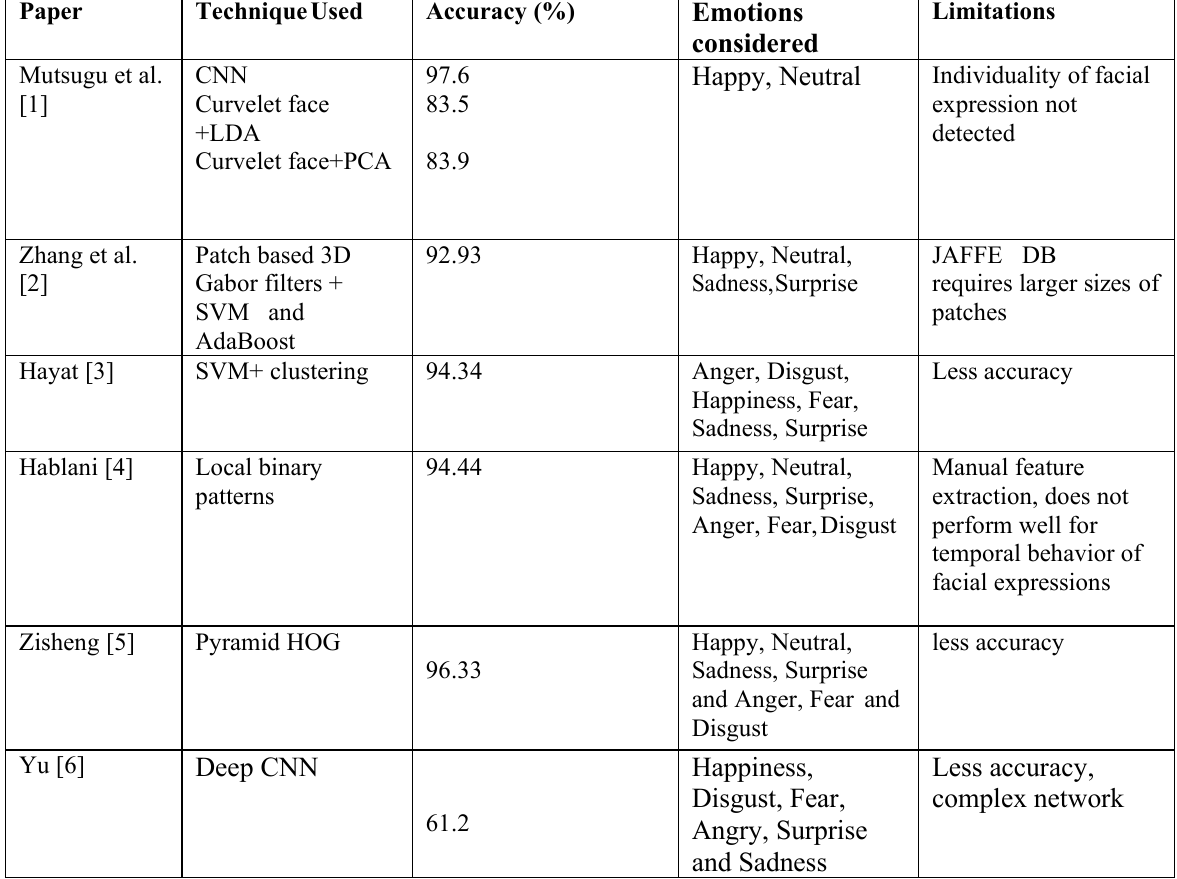
Table I. Comparison of Existing